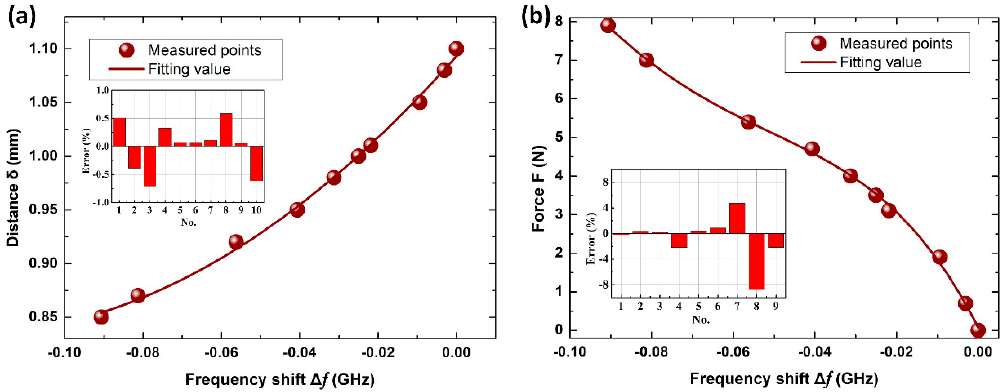
Figure 4. ( a ) Measured distances δ of different frequency shifts ∆ ƒ (wine red points) and the fitting relationship between δ and ∆ ƒ (wine red curve). ( b ) Measured applied forces, F, of different frequency shifts, ∆ ƒ, (wine red points) and the fitting relationship between F and ∆ ƒ (wine red curve). The insets in Figure 4a,b represent for the errors of the fitting values and the measured values of various distances, δ , and applied forces, F.